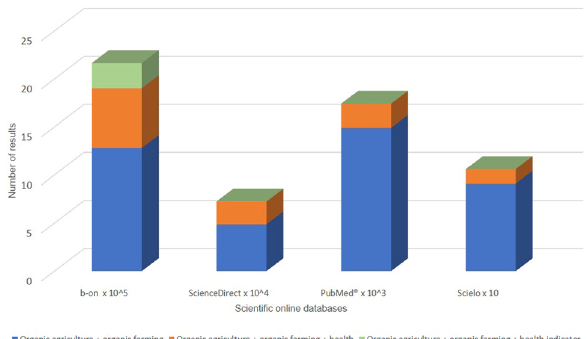
Figure 1: Results found in four online databases according to